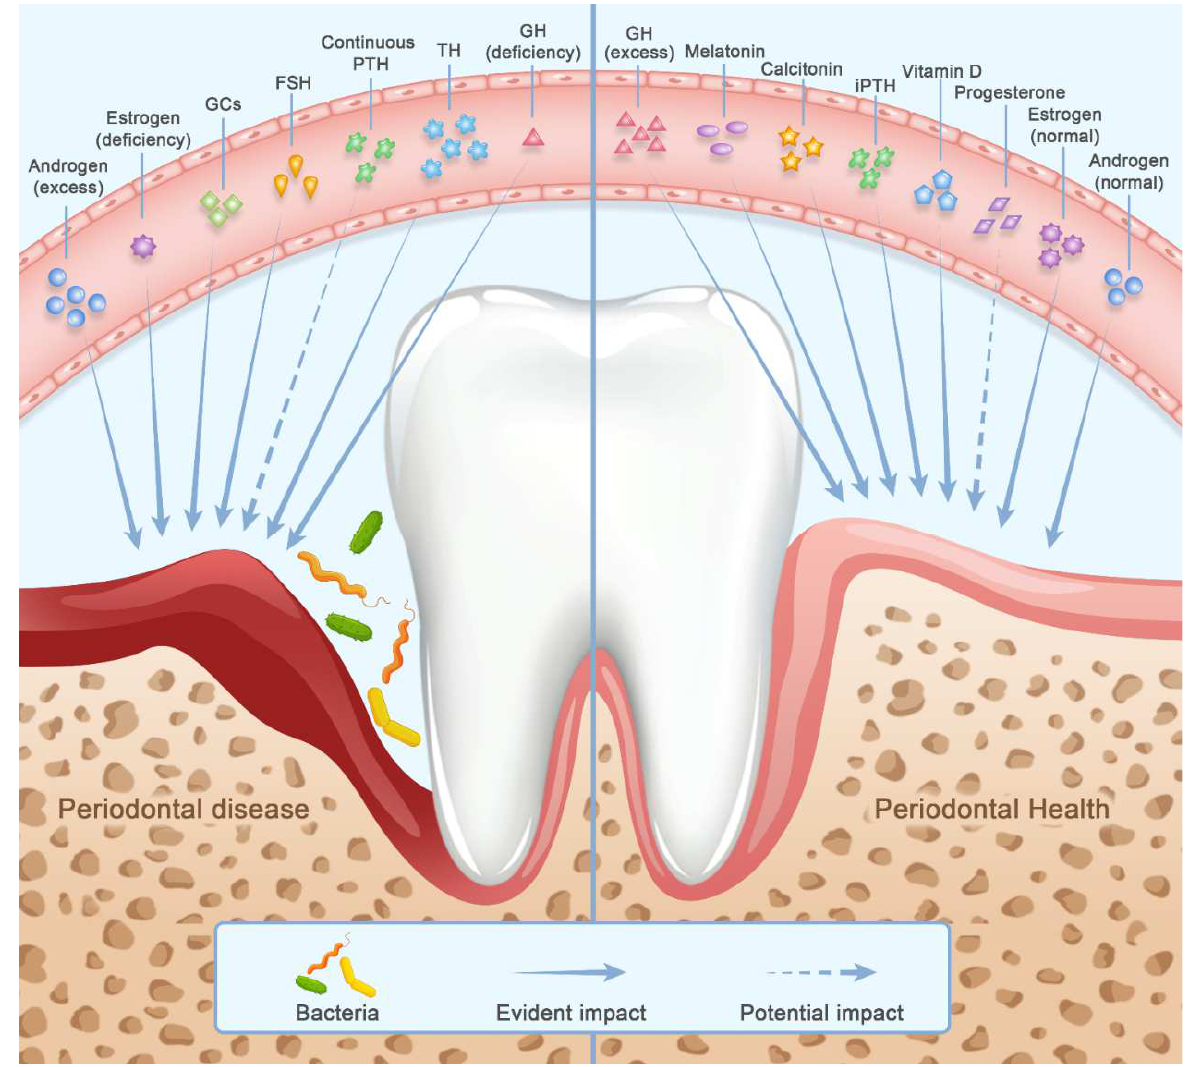
Figure 2. Impacts of hormones on periodontal status. There are multiple hormones that play a role in periodontal homeostasis, and their effects vary with hormone nature and circulating level. Androgen excess, estrogen deficiency, FSH, continuous PTH, GCs, TH, and GH deficiency are evident harmful factors, contributing to periodontitis. Moreover, continuous PTH is a potentially harmful factor. On the contrary, androgen and estrogen at a physiological level, progesterone, vitamin D, iPTH, calcitonin, melatonin, and GH excess are evident protective factors for periodontal health. Direct evidence for the impacts of progesterone and continuous PTH on periodontal tissues is still lacking yet. FSH follicle stimulating hormone; PTH, parathyroid hormone; GCs, glucocorticoids; TH, thyroid hormone; GH, growth